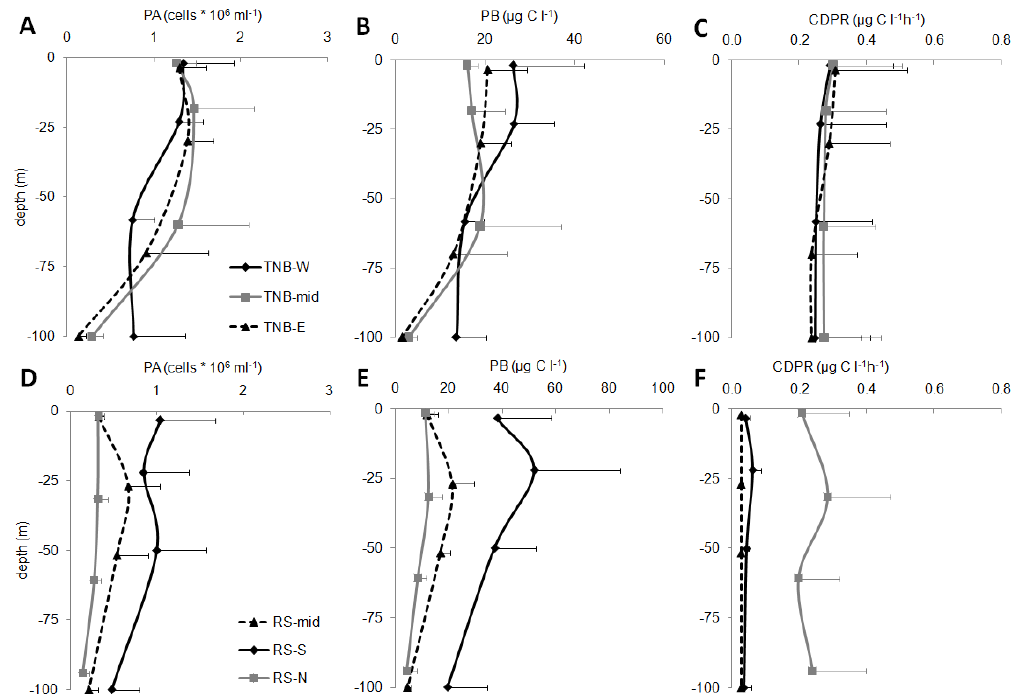
Figure 5. Vertical distribution of microbial parameters: PA (prokaryotic abundance, cells * 10 6 mL −1 ), PB prokaryotic biomass (µg C L −1 ), and CDPR (carbon dioxide production rates, µg C L −1 h −1 ) in coastal TNB (upper panels A – C ) and offshore RS (lower panels D – F ).